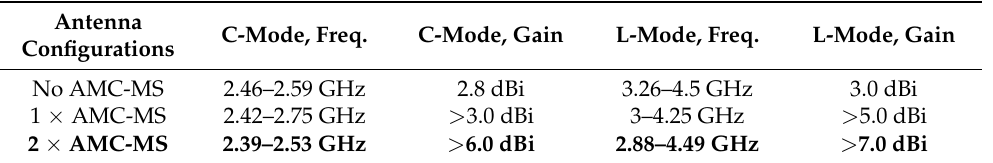
Figure 12. Parametric study showing the variation of “H1” on ( a ) S11, dB and ( b ) Gain, dBi. Table 2. Comparison analysis of antenna working modes without/with the presence of AMC-MS structures (layers).